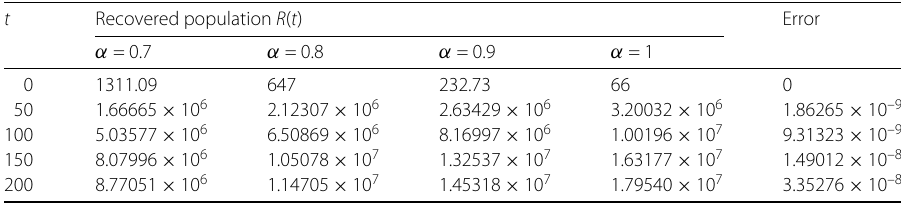
Table 6 Numerical result of recovered population R ( t ) for fractional parameter τ = 0.7,0.8,0.9,1 and comparison between classical and approximate